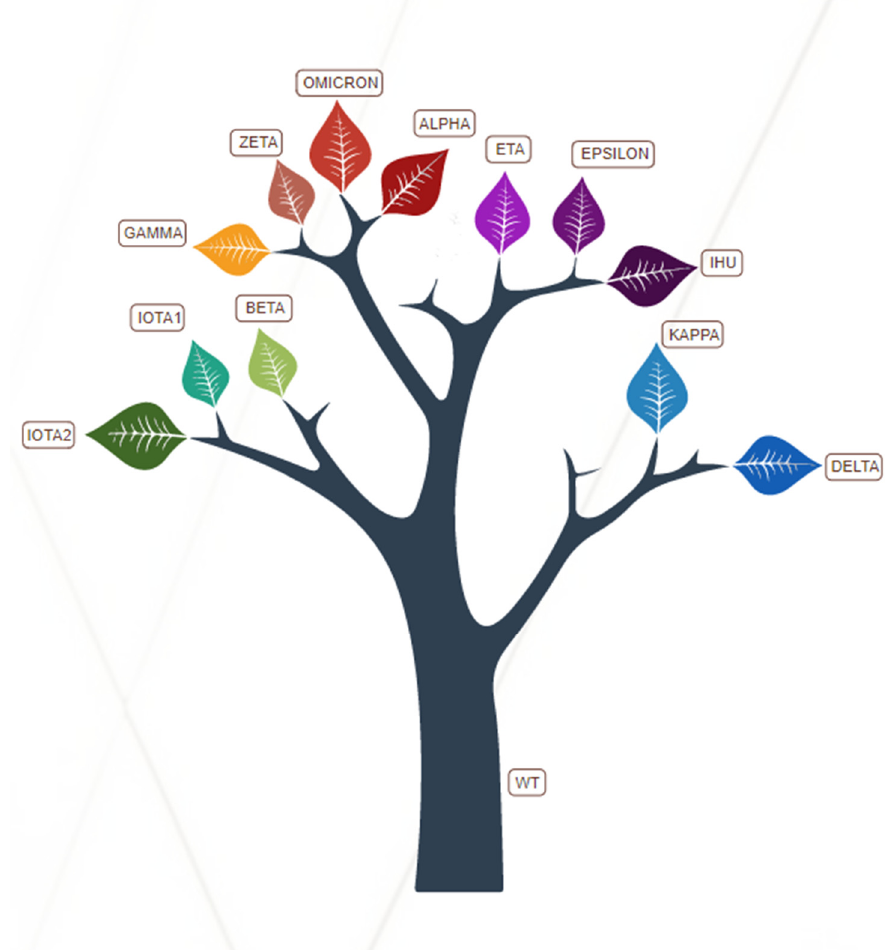
Figure 3. Graphical representation of the phylogenetic tree, included in the Spike Mutants portal constructed by the maximum likelihood method based on whole genome SARS-CoV-2 sequences.